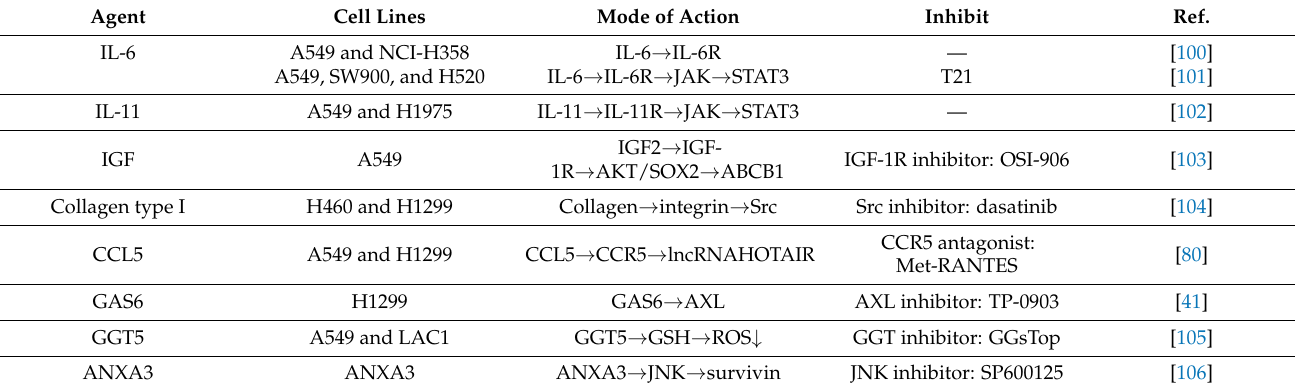
Table 2. Cancer-associated fibroblast-mediated drug resistance in